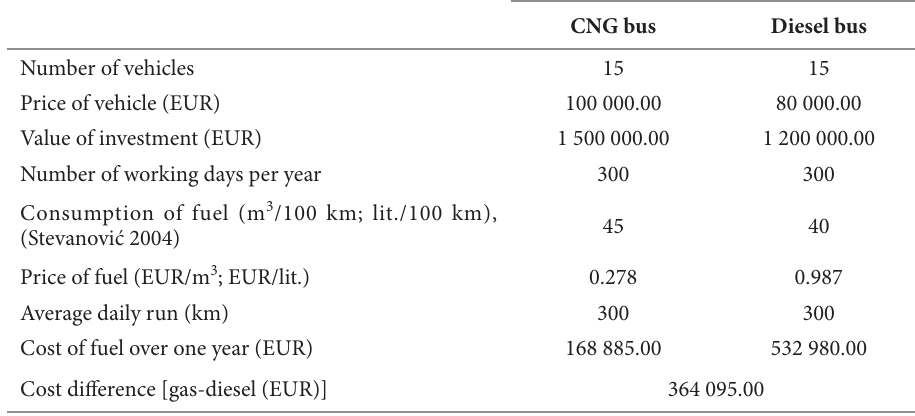
Table 6. Economic efficiency of gas propulsion on the basis of price difference over one year (Žeželj et al. 2007)